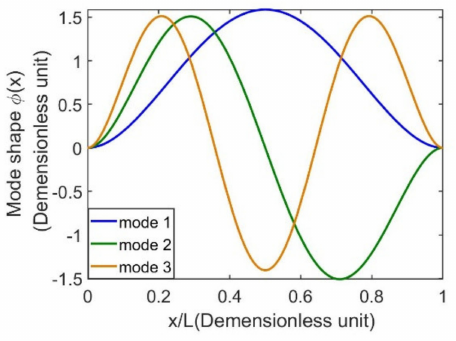
Figure 4. Normalized mode shapes of first three modes of doubly clamped